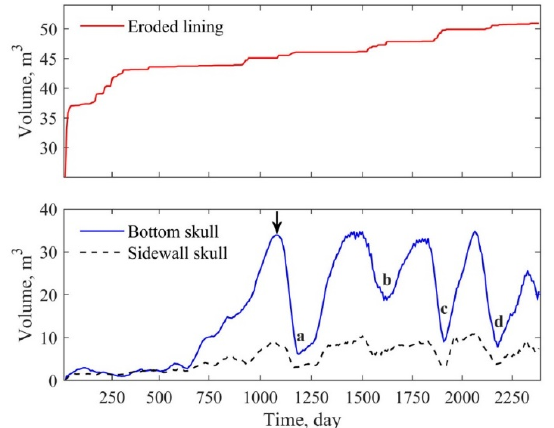
Figure 5. Evolutions of volumes of eroded lining ( upper panel), bottom skull (solid line, lower panel), and sidewall skull (dashed line, lower panel) within the hearth region considered by the wear model.